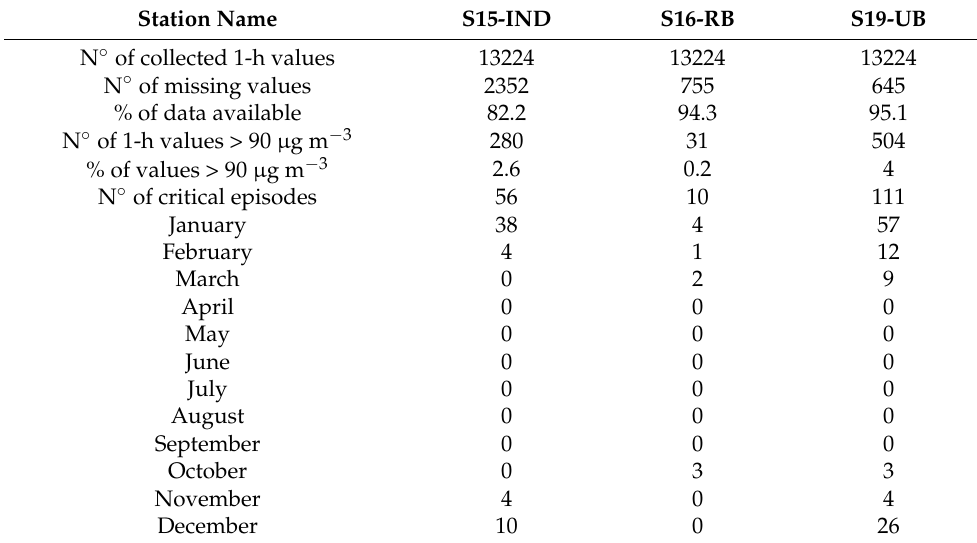
Table 4. Number of 1-h PM10 concentrations above 90 µ g m − 3 and relative number of critical episodes for S15-IND, S16-RB, and S19-UB across the period 28 June 2018-15 April